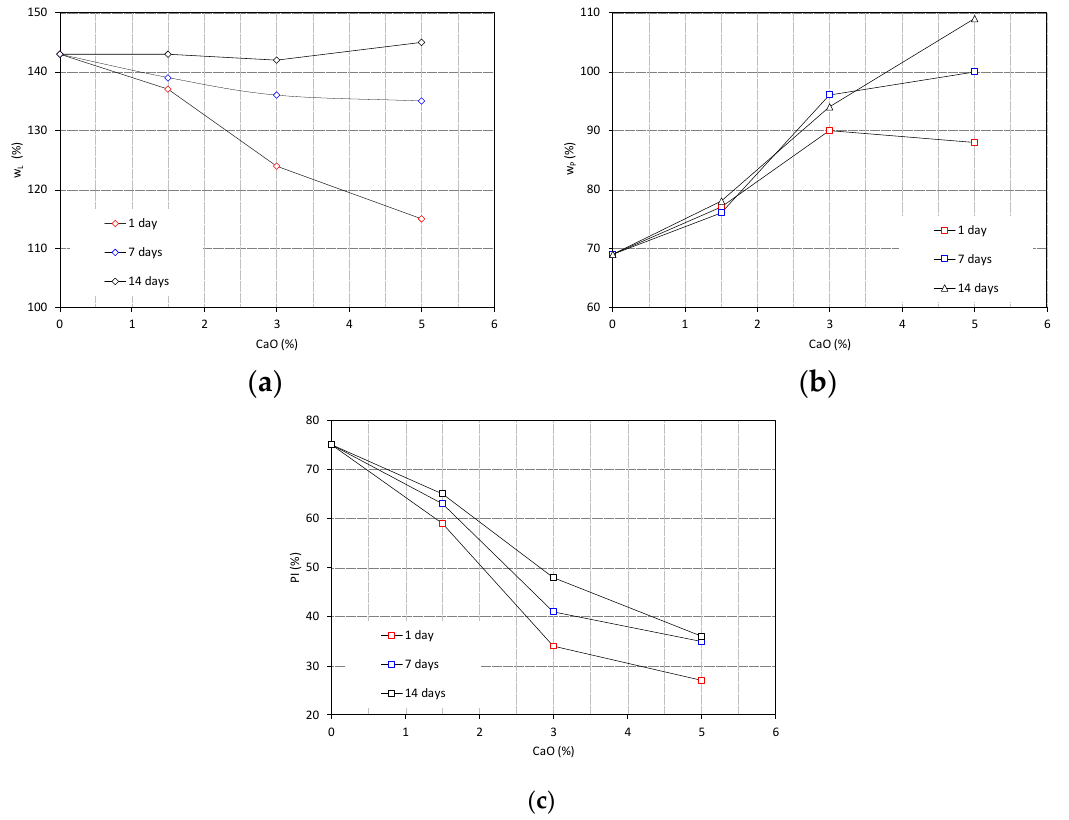
Figure 5. Changes of the plasticity properties of lime-treated bentonite as a function of the lime content and curing time: ( a ) liquid limit (w L ), ( b ) plastic limit (w P ), and ( c ) plasticity index (PI).